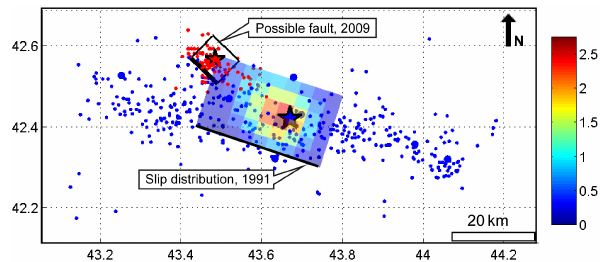
Figure 4. Surface projection of the co-seismic slip distribution of Tan and Taymaz (2006) for the 1991 earthquake. The blue dots are the aftershocks ( M> 3) and main shock (blue star) of the earthquake to the M w = 6 . 9 from Seismic Monitoring Center (SMC) in the Georgia catalog. The red dots represent the aftershocks located by SMC from the time of the earthquake to the M w = 6 (red star) event of 7 September 2009. The black frame presents the possible fault plane for the 2009 earthquake, calculated with Okada code based on the CMT solution. Bold lines show the edge of planes close to the